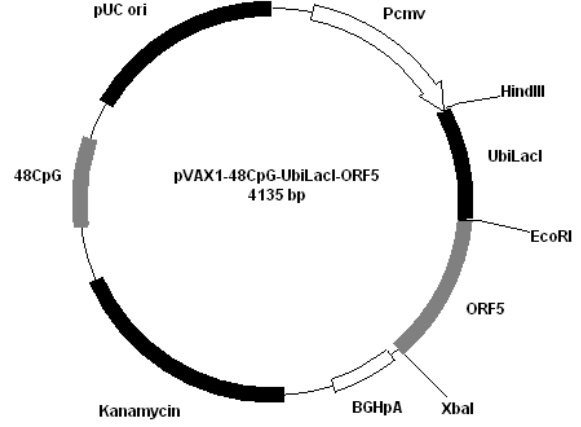
Figure 5. Plasmid